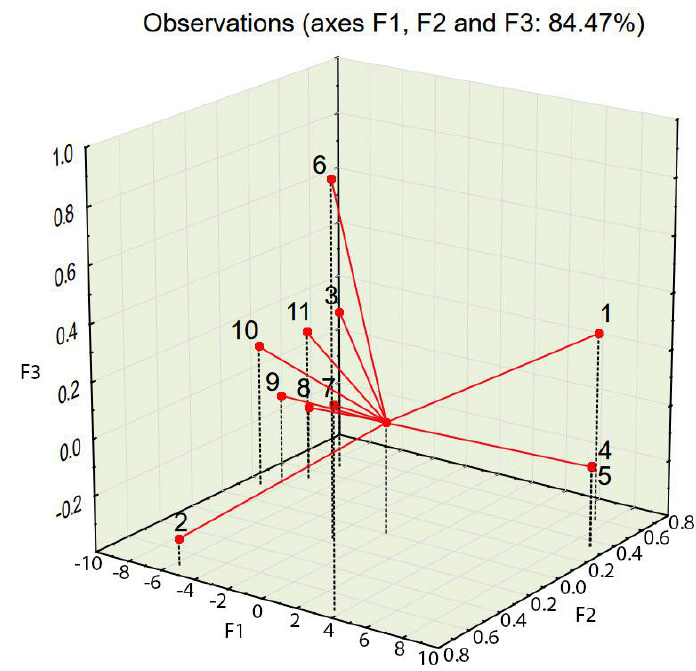
Figure 8. PCA projection of variables set in a 3D factor loading space (for the variable designations, see Table 5).